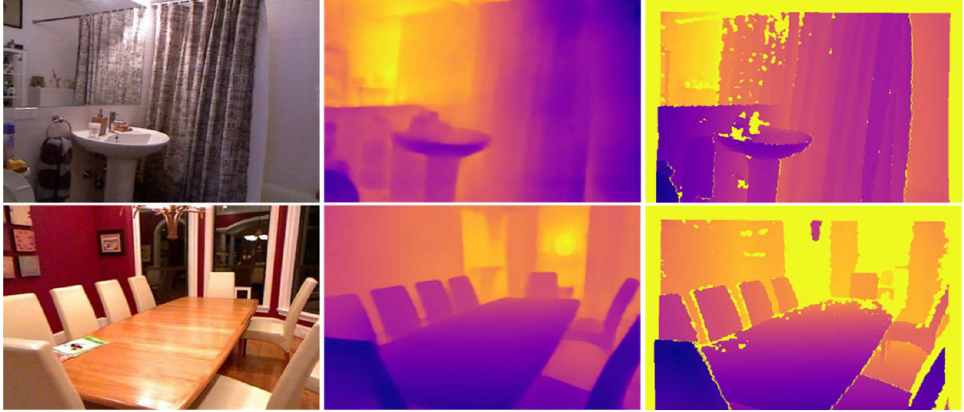
Figure 1. Example of an estimated depth map from the proposed network. From left to right: input image, our estimated depth map, and ground truth.